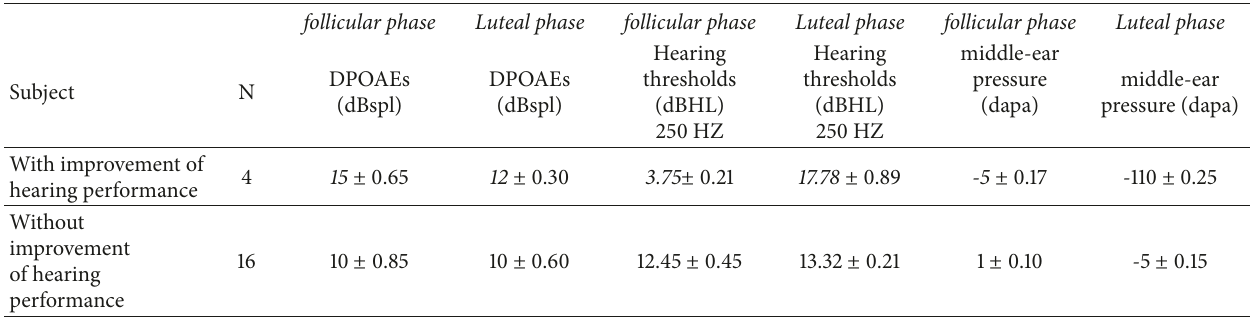
Table 1: Mean and standard deviation of physiological audiology tests of twenty healthy female in follicular-luteal phase.